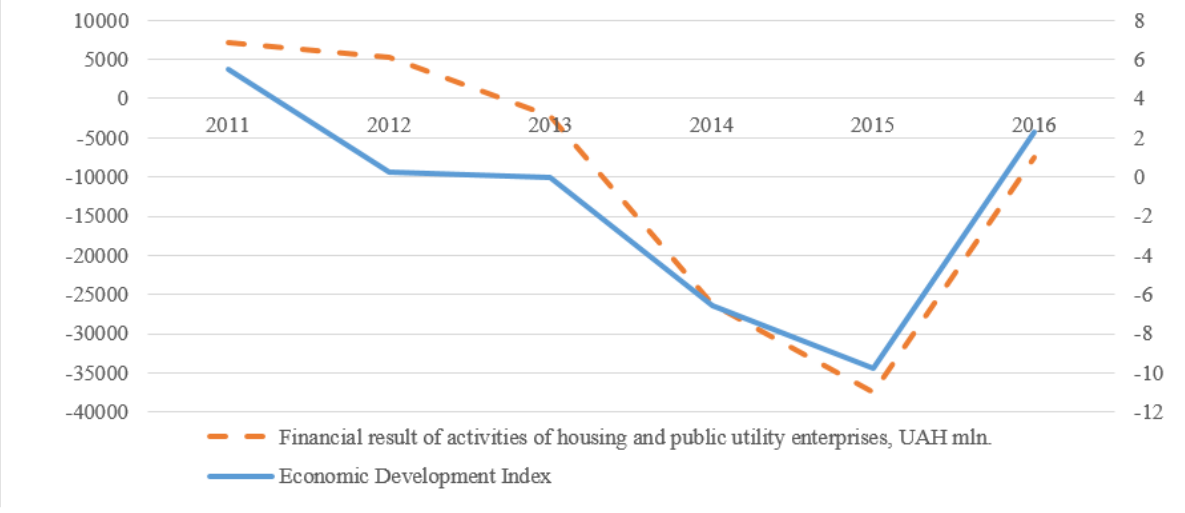
Figure 3. Growth of the index of economic development of Ukraine and financial result of housing and utility enterprises activity in the period